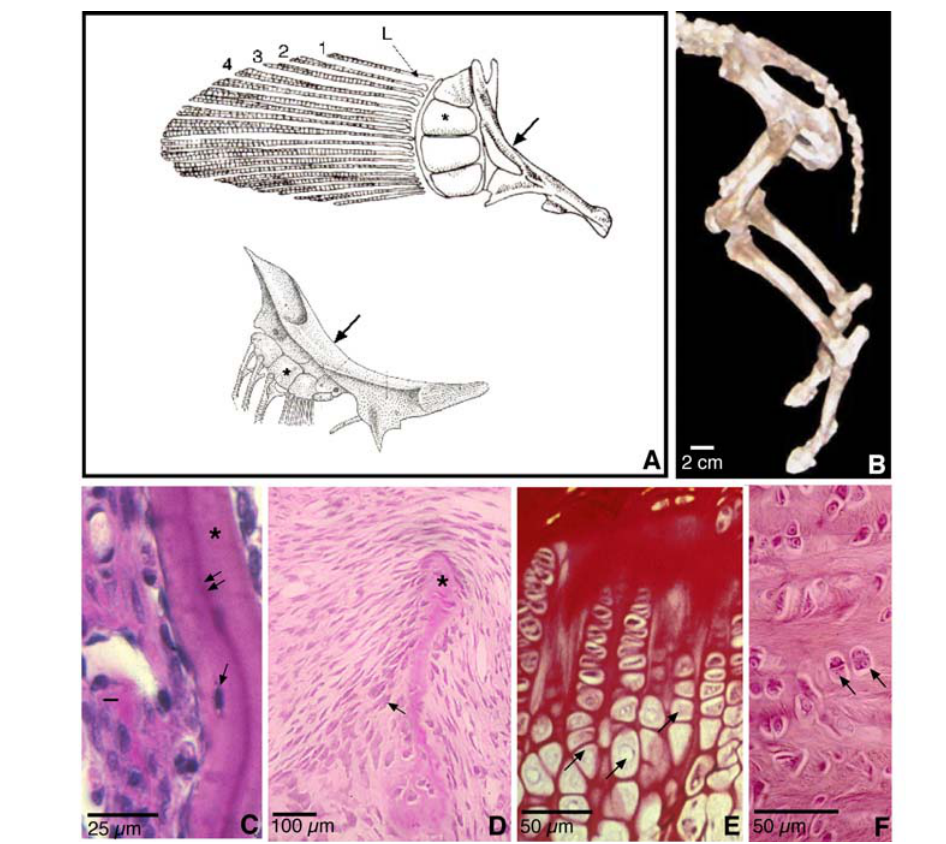
FIGURE 1. (A) Schematic representation of a pectoral fin skeleton of a teleost ( Gobius ). Observe how the dermal rays, mostly formed by lepidotrichia (L) (only numbered from 1 to 4), are organized distal to the cleithrum (arrow) and hypercoracoid bones (asterisk). Below this general scheme, observe a detail of the scapular girdle of Trigla (differentiating by endochondral ossification and similar to the one shown in Gobius ) (adapted from Grassé[28]). In rhipidistian fishes, the dermal rays start disappearing and the basal bones overgrow as a general vertebrate evolutionary trend until the rays are completely absent in the limb as in actual birds or mammals. (B) The posterior part of Ovis aries (sheep) skeleton shows how the basal bones overgrow, articulate, and bifurcate forming the digits (bottom), reaching large proportions as compared to actinopterygian fishes. (C) The dermal bone of the rays is also segmented and bifurcated. In cross-section, obtained from a caudal fin of a C. auratus specimen, the dermal bone (lepidotrichia) is a parenthesis-like structure (asterisk) — in this picture, only one element of the parenthesis is shown — that surrounds a loose connective tissue with fibroblasts and blood vessels immersed in the tissue. In the case of C. auratus , this is a cellular bone as cells can be observed inside the lepidotrichia (arrow). The lepidotrichia is divided into two parts, one internal and one external, separated by a specially glycosilated ECM (double arrows). (D) Detail of a bone growing by intramembranous ossification in humans. Observe a central condensation (asterisk) and various strata of osteocytes (arrow) providing a general laminar ordering. (E) Detail of a bone growing by endochondral ossification in a rat ( Ratus ratus ). Observe the bone matrix (in red) with osteocytes. Long bones grow at the epiphyseal plate by the hypertrophy of a template of cartilage (arrows) and its substitution by migrating osteoblasts. (F) Fibrous cartilage. Observe chondrocytes (arrows) and fibrillar ECM surrounding them. Magnifications are shown by